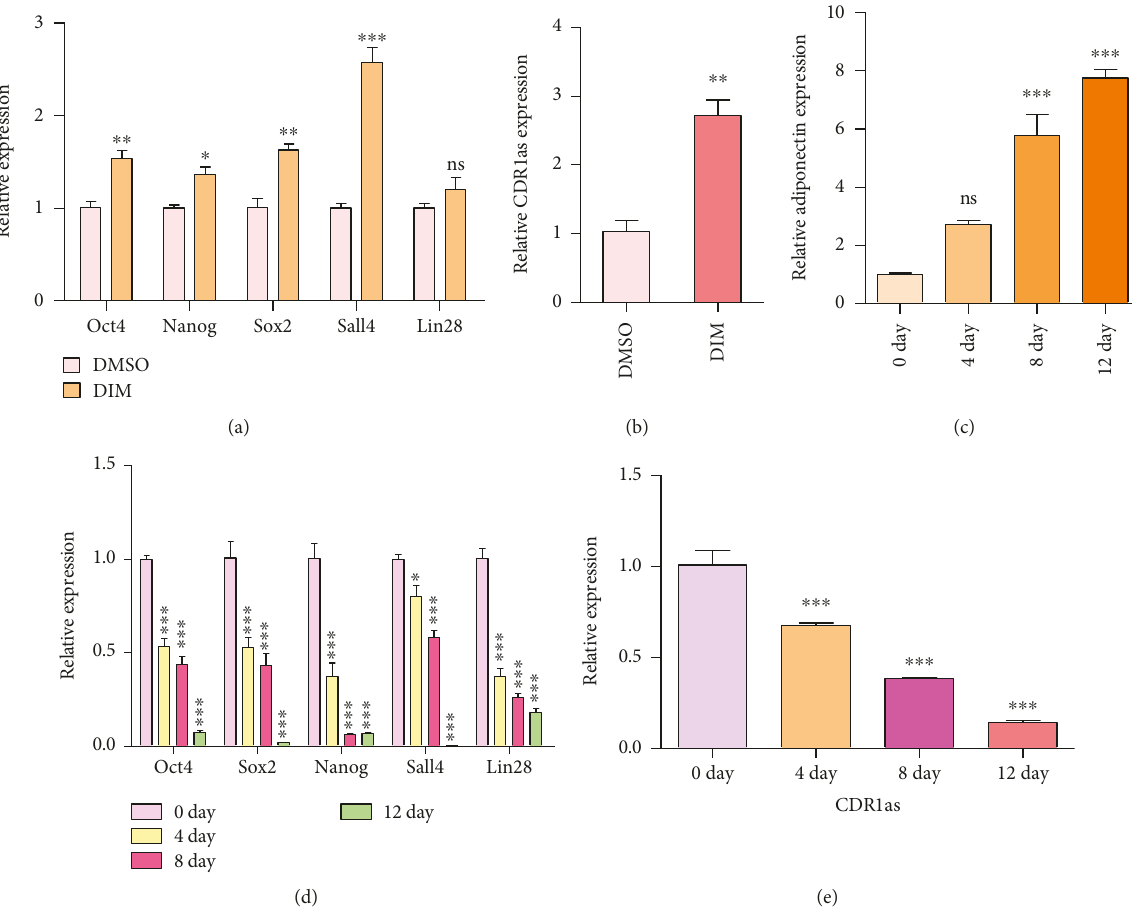
Figure 2: CDR1as expression level varied with the state of hucMSCs. (a) The expression levels of STFs were detected by RT-qPCR after the DIM treatment of hucMSCs. (b) After treating hucMSCs with DIM, CDR1as expression was detected by RT-qPCR. (c) The expression level of adiponectin was detected by RT-qPCR in the adipogenic di ff erentiation of hucMSCs. (d) The expression levels of STFs were detected by RT- qPCR with hucMSC adipogenic di ff erentiation. (e) The expression level of CDR1as was detected by RT-qPCR in the adipogenic di ff erentiation of hucMSCs. ns: no signi fi cance; ∗ P < 0 05 ; ∗∗ P < 0 01 ; ∗∗∗ P < 0 001